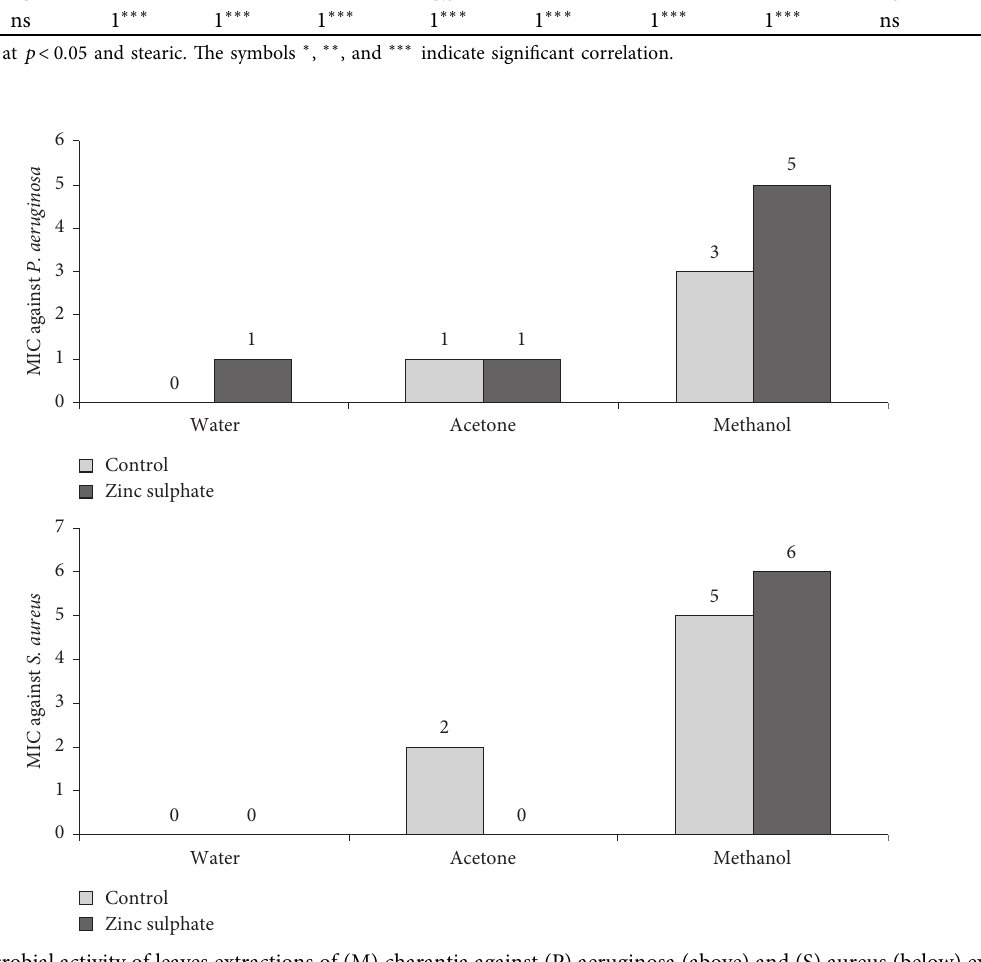
Figure 5: Antimicrobial activity of leaves extractions of (M) charantia against (P) aeruginosa (above) and (S) aureus (below) expressed as minimum inhibitor concentration to inhibit growth of bacterial